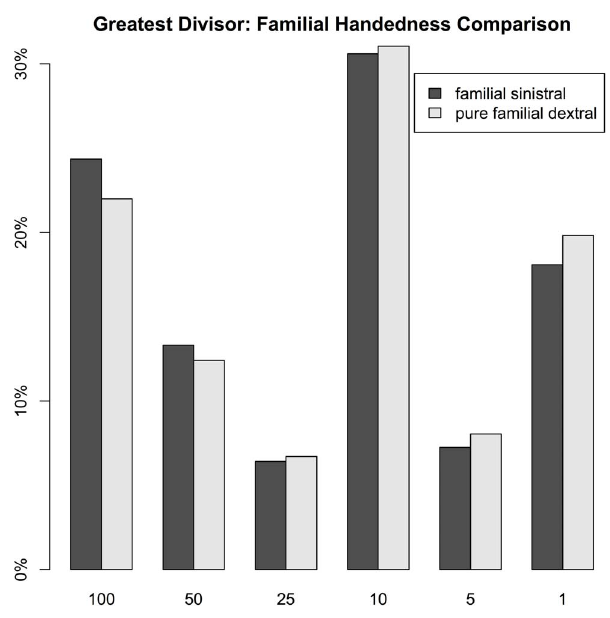
Figure 2. Comparison of Greatest Divisor Frequency by Familial Laterality. A greater percentage of all the answers by familial sinistrals were multiples of 100 or 50 than for pure familial dextrals. Pure familial dextrals more frequently used numbers that were only divisible by 25, 10, 5, or 1, but not by 100 or 50.